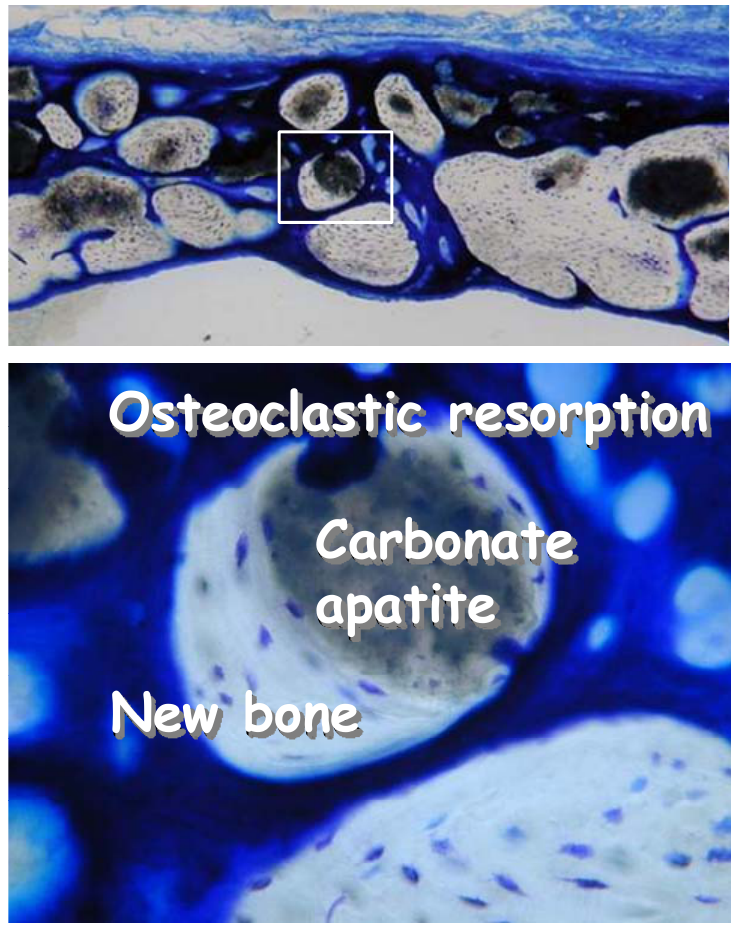
Figure 9. Histological pictures of carbonate apatite 24 weeks after implantation in a bone defect made to the cranial bone of rats. After 24 weeks, most of the carbonate apatite granules were replaced by new bone. Osteoclastic resorption can be seen along with new bone when carbonate apatite was not